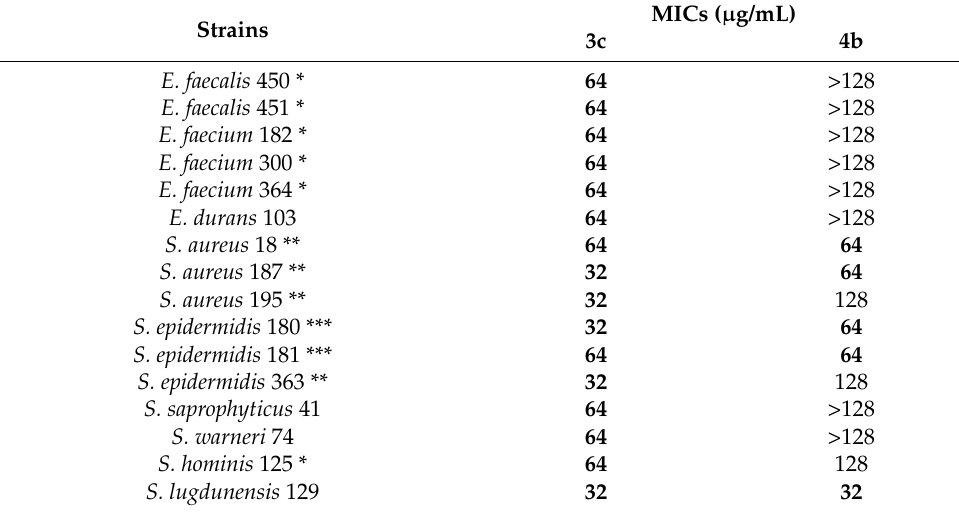
Table 1. MIC values of pyrazoles 3c and 4b against the bacteria of Gram-positive species, obtained from experiments carried out at least in triplicate, expressed as µ g/mL.